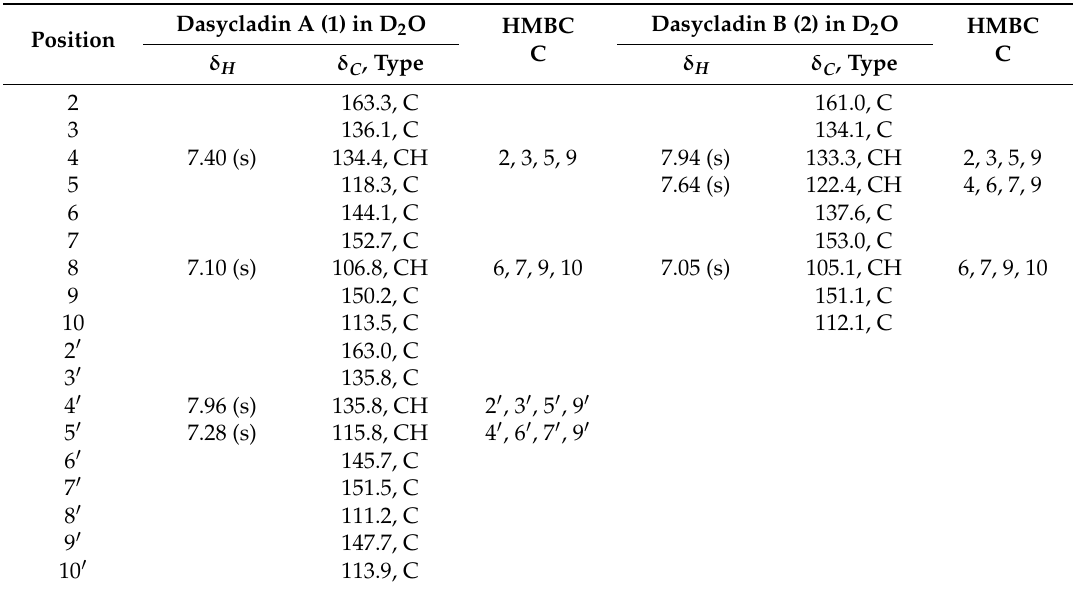
Table 1. NMR shift values of compounds isolated from the marine green alga Dasycladus vermicularis ; spectra were recorded on a 600 MHz NMR instrument in deuterated